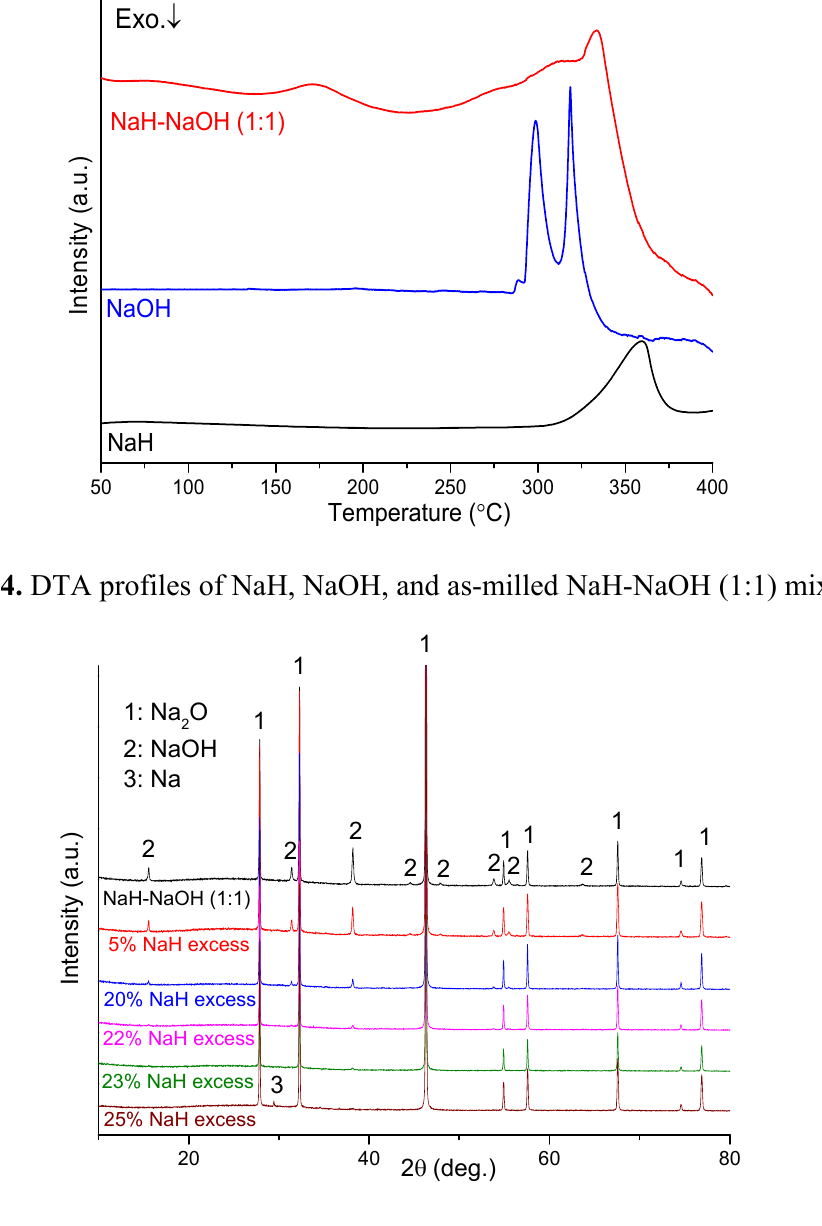
Figure 5. PXD patterns of NaH-NaOH with varying hydride:hydroxide molar ratio after dehydrogenation at 400